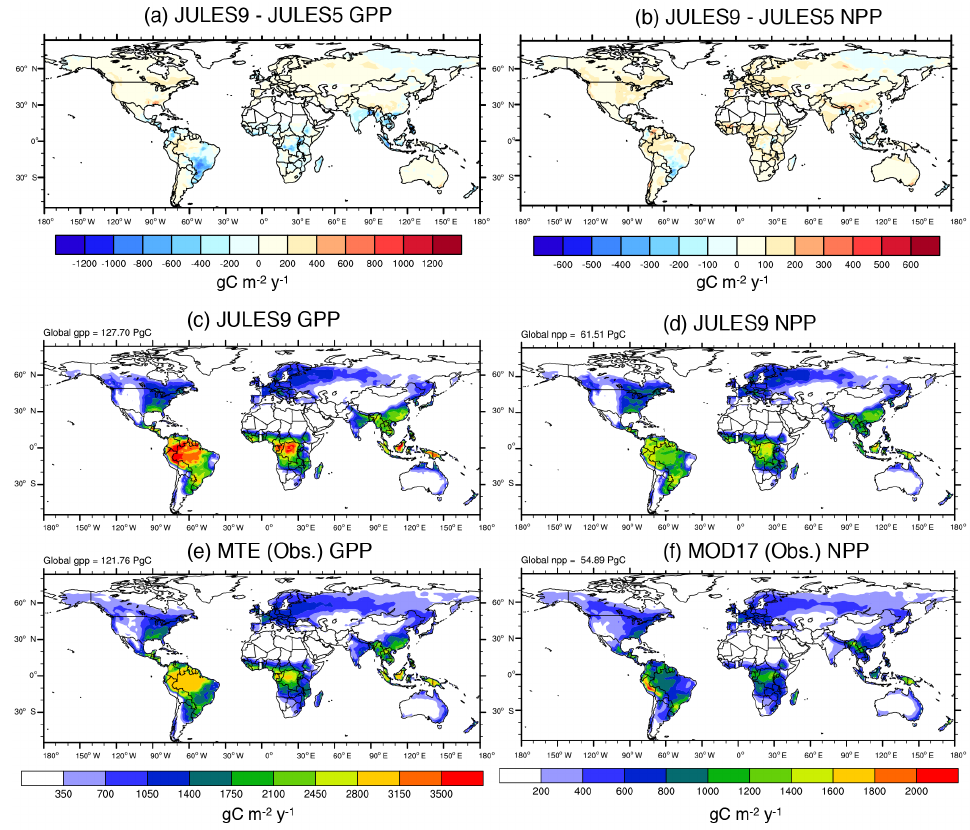
Figure 8. Global maps of carbon cycle fluxes from 2000 to 2012. The observation sources are MTE (GPP) and MODIS MOD17 (NPP,